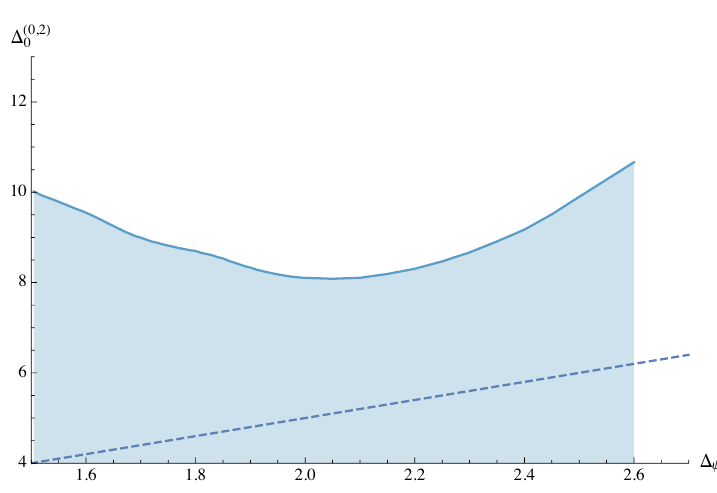
Figure 17 . Upper bound on the dimension of the (cid:12)rst neutral (0 ; 2) NTS operator. The shaded region is the allowed one. The bounds has been computed at (cid:3) = 20. The dashed line represents the GFT.